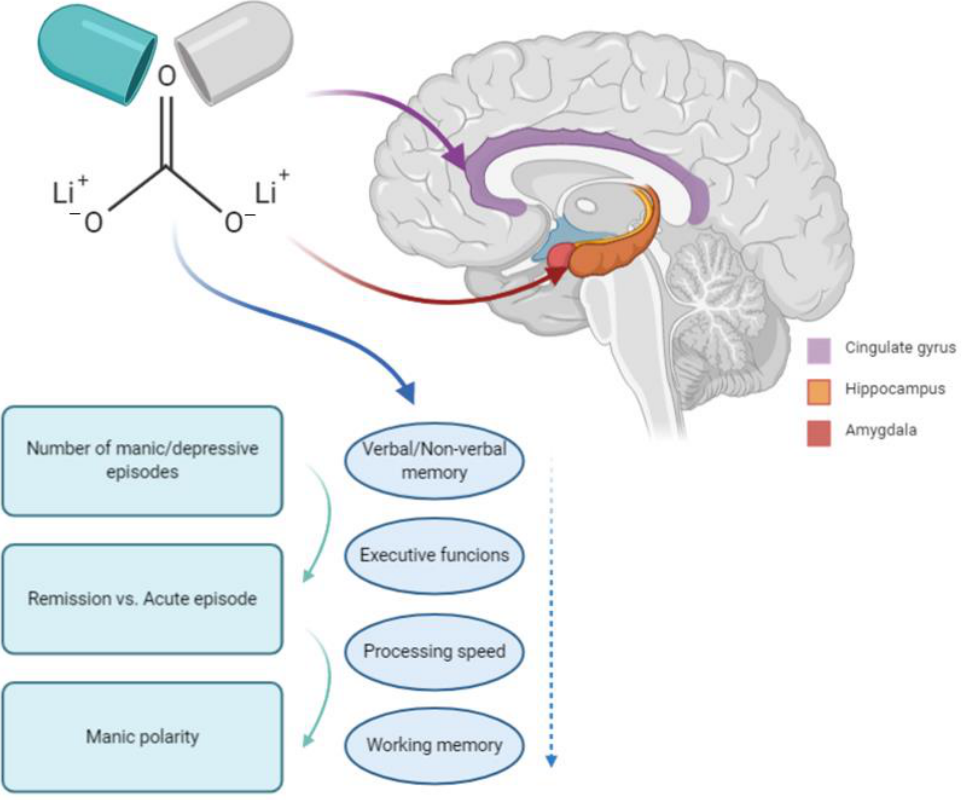
Figure 1. The role of lithium in bipolar disorder and neurodegeneration.